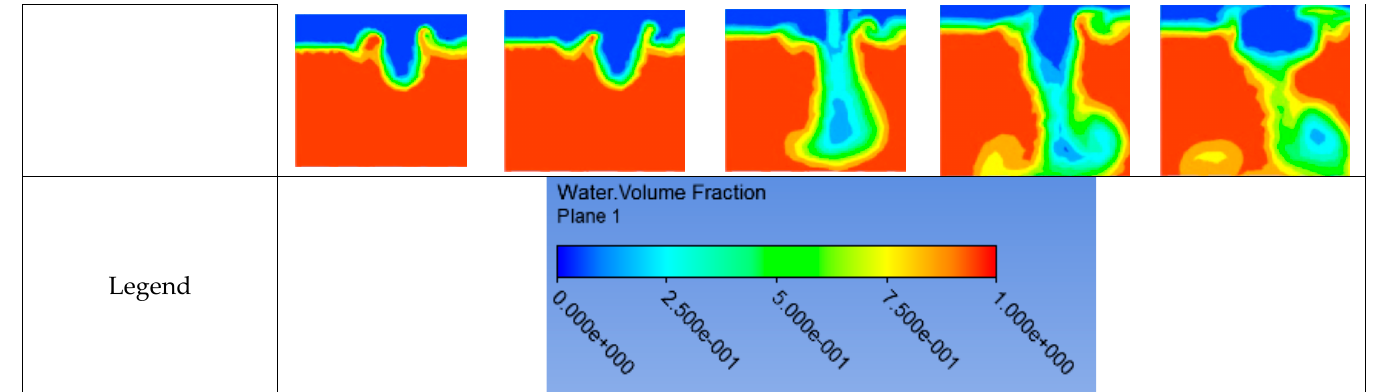
Figure 15. Comparison of experimental and CFD results with integrated UDF.